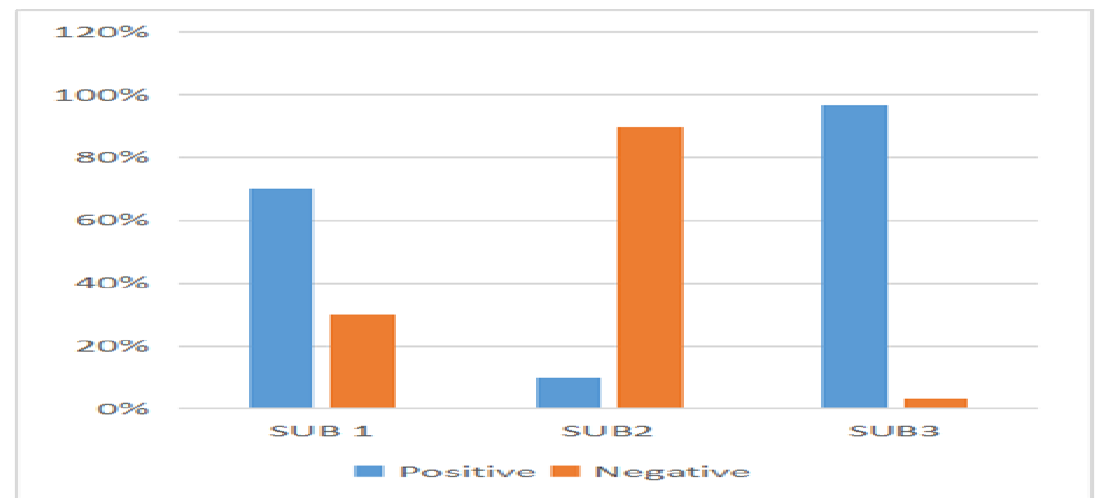
Figure 4. Percentage of SUB (1-3) genes in M.Canis